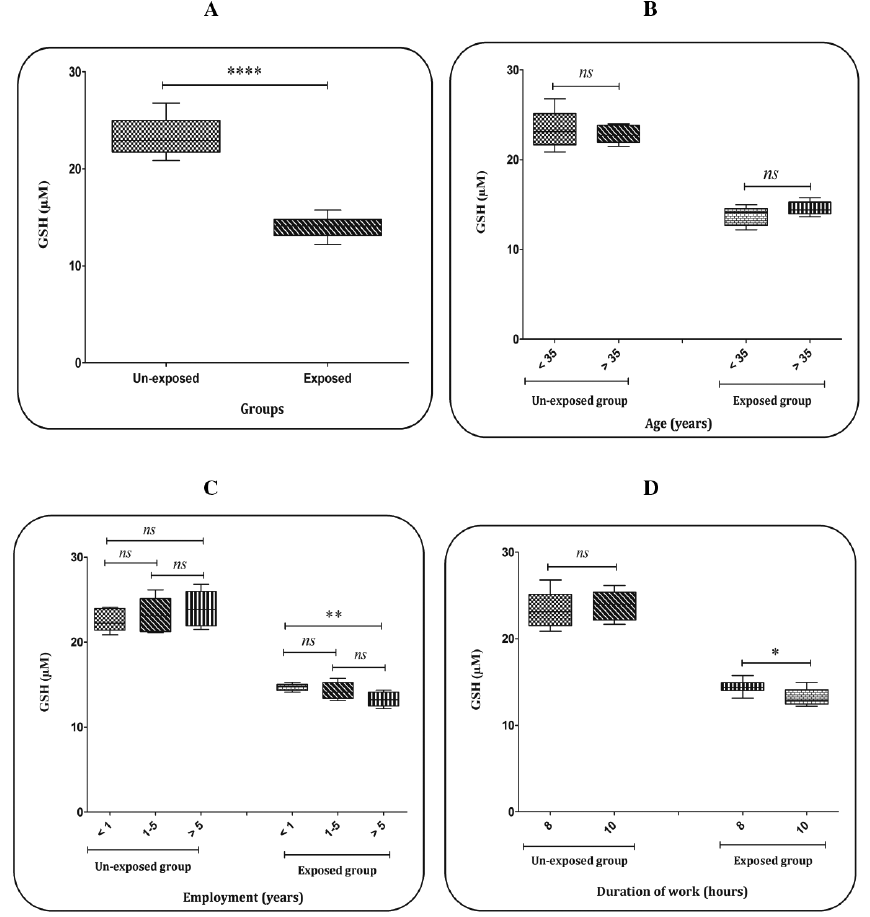
Figure 4: GSH content assay. (a) Comparison between exposure and non-exposure groups. (b) Comparison between the exposed and unexposed groups based on age (year). (c) Comparison between the exposed and unexposed groups based on employment (year). (d) Comparison between the exposed and unexposed groups based on duration of work (hours). Data are presented as mean ± SD (n = 20). * P < 0.05, ** P < 0.01 and **** P <